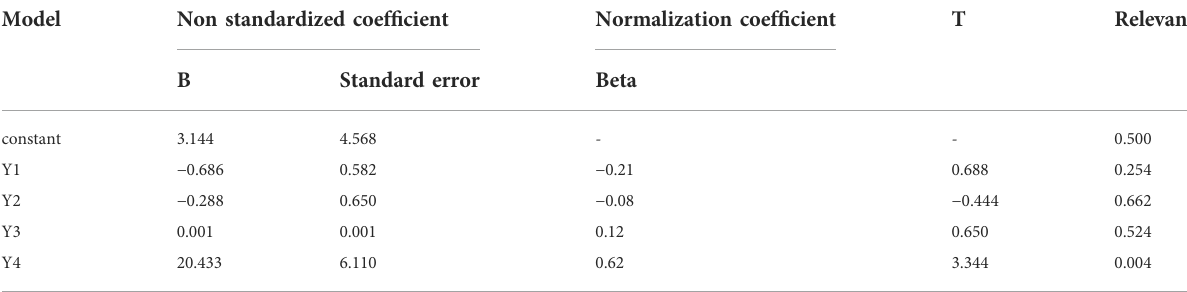
TABLE 4 Table of regression coef fi cients of various factors (the single-phase gas fl ow stage).